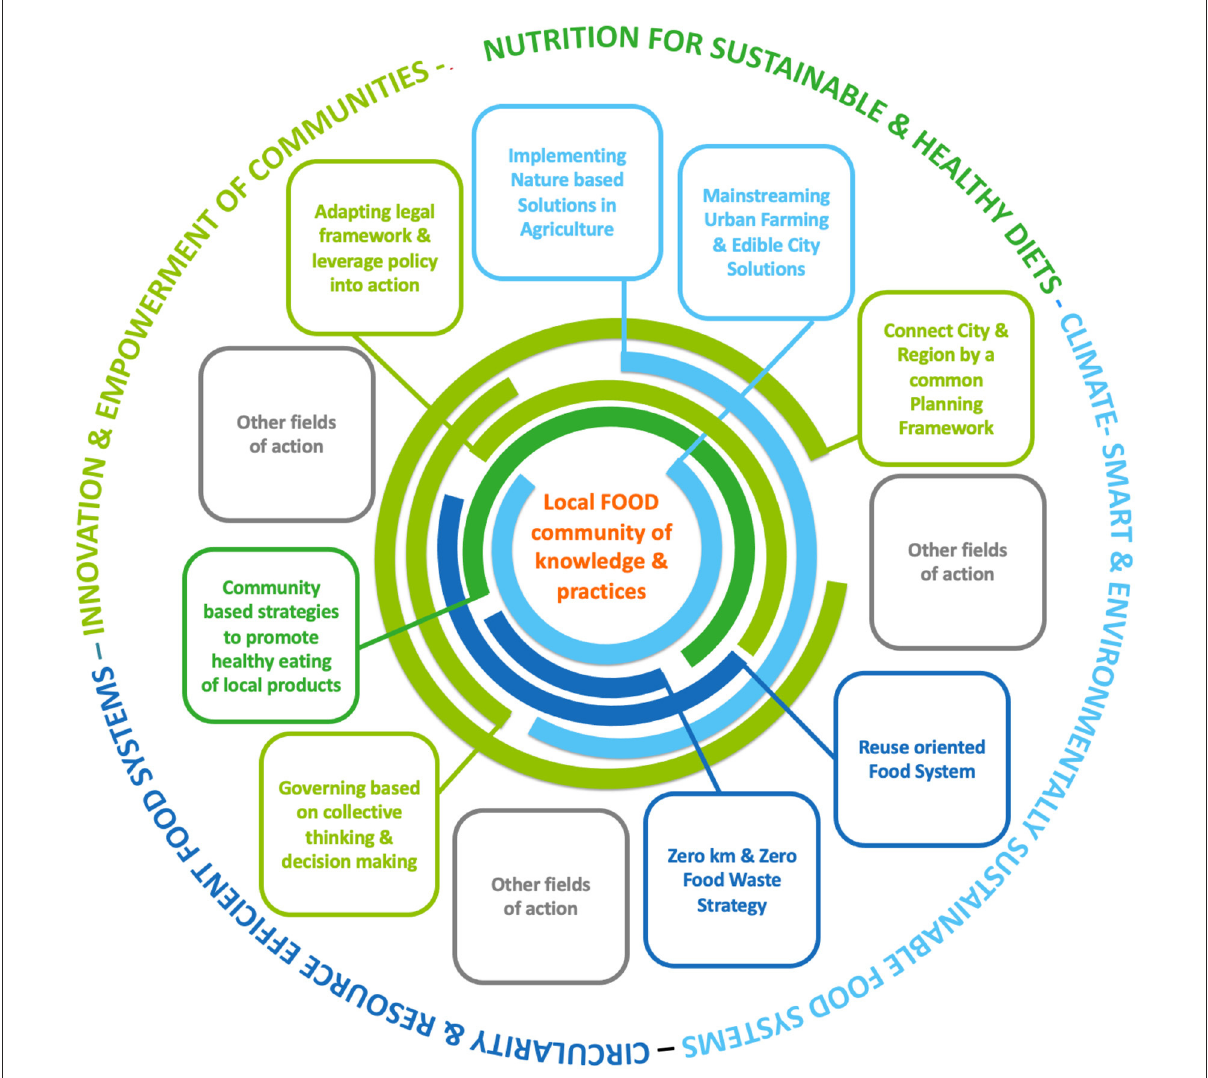
FIGURE3 The Framework to develop possible food futures is adapted from Food 2030 (European Commission et al., 2020) and places the local communities of each City Region in the center of different action fields. The action fields address the principals of the European Food2030 strategy (European Commission et al., 2020) and regularly support more than one of the Food 2030 principles, which are indicated by different colors; e.g. the implementation of nature based solutions in the regional agriculture or the mainstreaming of urban farming and edible city solutions aim mainly at climate-smart and environmentally sustainable food systems (light blue) and, at the same time, also support nutrition for sustainable and healthy diets (dark green), and the circularity and resource efficiency of food systems (dark